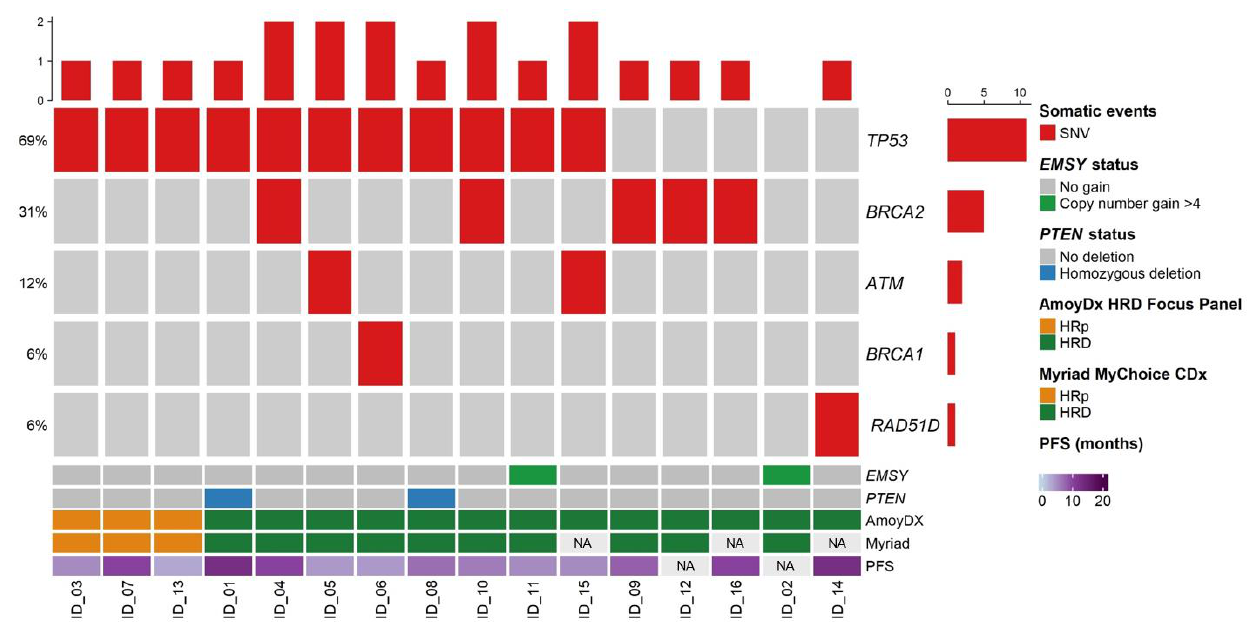
Figure 1. Oncoprint of mutated HRR genes identified in the study cohort. Cases sorted by HRD status. SNV were evaluated by BRCA-Expanded Panel, PTEN homozygous deletion, and EMSY copy number gain were evaluated by FISH analysis. NA = not available.